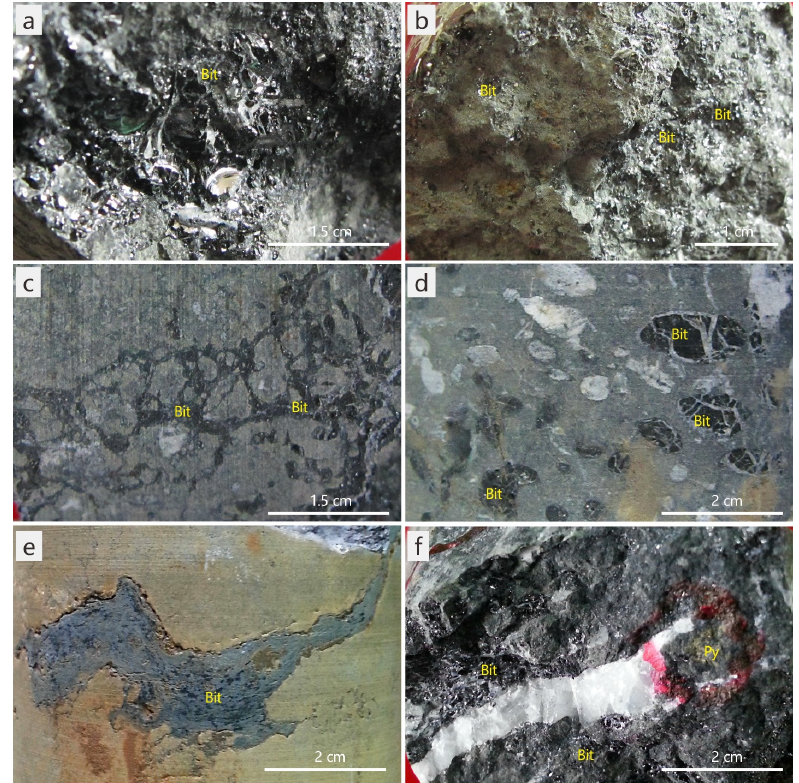
Figure 6. The distribution of bitumen in the paleo-reservoir from Qinglong antimony ore field. ( a ) Black bitumen hard and brittle, with resinous luster and conchoidal fracture; ( b ) bitumen in the pores of tuff; ( c ) bitumen between volcanic breccia; ( d ) bitumen in the vesicles of basalt; ( e ) bitumen in the caverns of limestone. ( f ) The paragenesis of pyrite and bitumen. Abbreviations: Bit = Bitumen; Py = Pyrite.